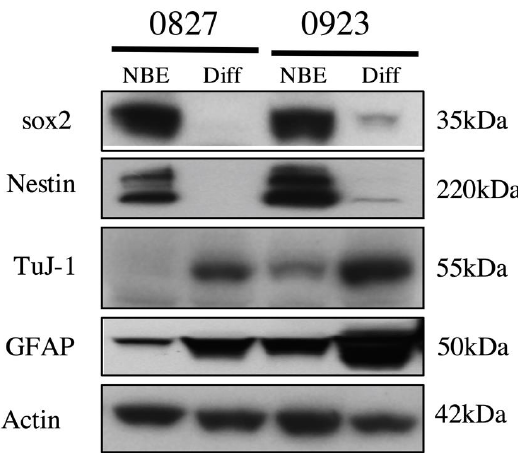
Figure A3. GBMSCs have appropriate stemness markers. Western Blot showing stemness of cells used in manuscript. 0827 and 0923 refer to IDH1 wt 1 and IDH1 wt 2, respectively. NBE refers to the cells in the “stem” state, and “Diff” refers to the cells after ten days of culture in media containing 10% FBS. Cells were in the “NBE” or “stem” state for all experiments presented in the manuscript. Molecular markers for stemness included are sox2 and Nestin. Markers of differentiation are TUJ-1 and GFAP. Actin served as the loading control.